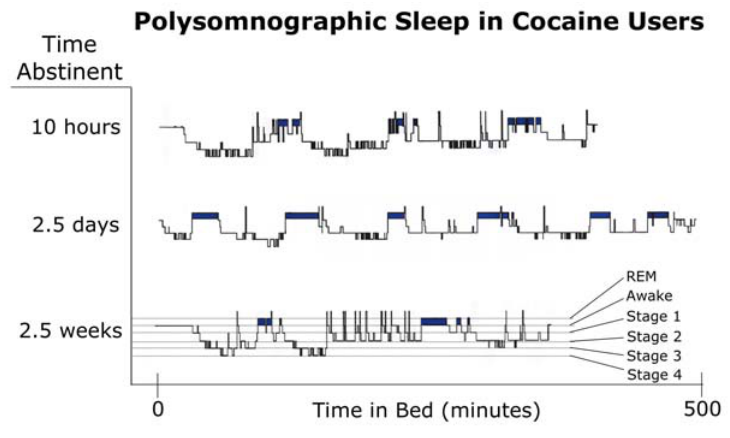
FIGURE 1 . Characteristic examples of polysomnographically measured sleep at different points along the first 3 weeks of abstinence. On the first night of sleep, 10 h after administration of 12 i.v. doses of 32 mg cocaine/70 kg body mass, REM sleep is suppressed with decreased REM sleep time and relatively increased REM latency. Slow-wave (stages 3 and 4) sleep is prominent in the beginning of the night. Sleep latency is somewhat increased and total sleep time is decreased. At 2.5 days abstinent , a rebound in REM sleep occurs with decreased REM latency and increased REM sleep time. Slow-wave sleep is much less prominent, sleep latency has decreased, and total sleep time has increased. After 2.5 weeks of abstinence , sleep is insomnia-like, with increased sleep latency, low sleep efficiency (% time spent asleep while in bed), and decreased total sleep time. REM sleep time is very short despite a REM latency that is decreased compared to healthy subjects, and the proportion of slow-wave sleep has increased relative to 2.5 days abstinent. Excursions of the hypnograms above the REM line indicate movement or other